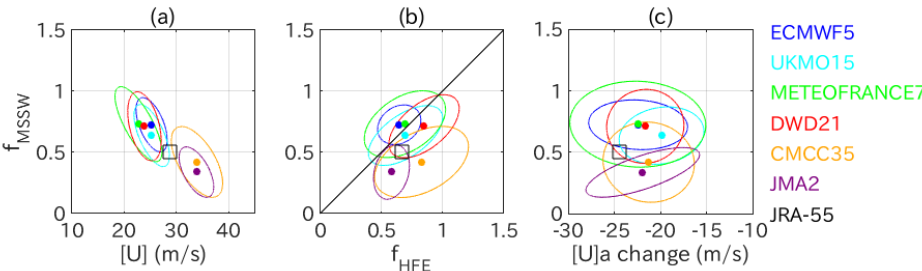
Figure 6. ( a ) Scatter plot between the climatological zonal mean zonal wind at 60° N, 10 hPa, and MSSW frequency, as plotted in Figure 3. Panel ( b ) uses the HFE frequency instead of the climatological zonal wind. Black diagonal line denotes the y = x line. Panel ( c ) uses the mean time change in anomalous zonal wind at 60° N, 10 hPa in response to the HFEs, i.e., from lag = −10 to 0 day. Table 2. Correlation coefficient values between the key quantities. Three left columns correlate the MSSW frequency with the mean VS, HFE frequency, and mean time change in the anomalous zonal wind in response to the HFEs (see also Figure 6). The rightmost column correlates the mean VS with the HFE frequency. The values for each system are those among all ensemble members. The row “Ensemble means” uses the ensemble means from the six systems. Asterisk denotes statistical significance at the 95% level (see Table